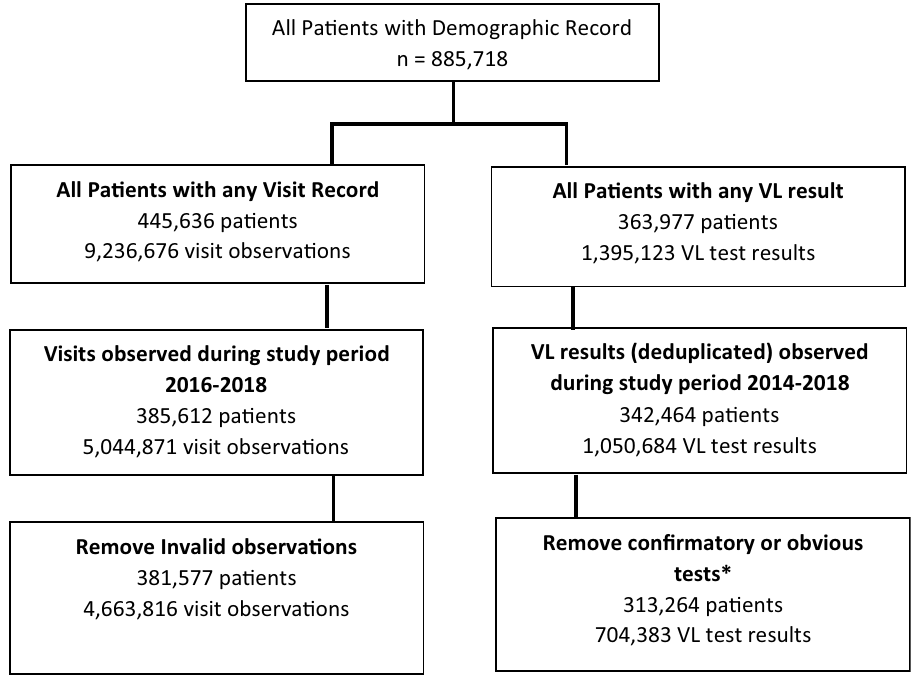
Figure 1. Flow chart of data source inclusion. * Notes : All VL tests immediately following a high test (> = 1000) and subsequent tests done < 6 months after first test removed. All visits with a ‘next appointment date’ that was either missing or more than 99 days were